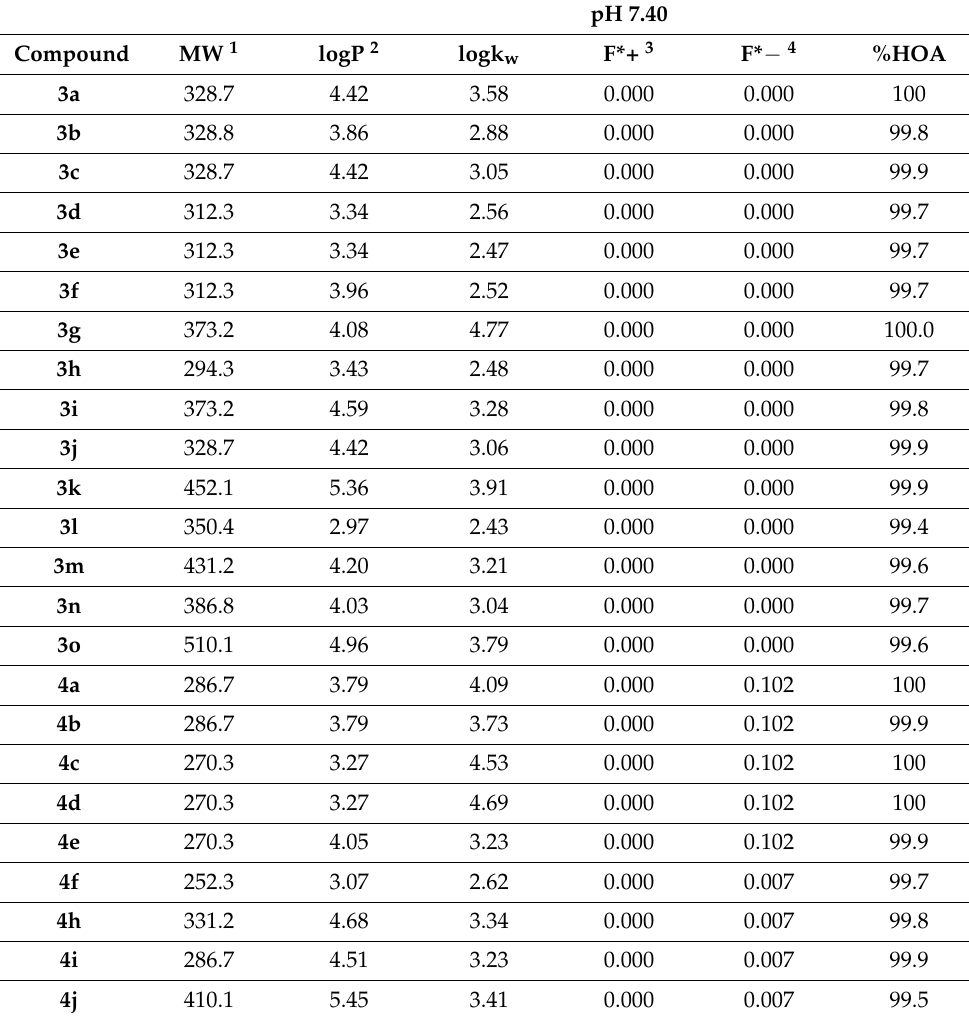
Table 6. Physicochemical properties, chromatographic indexes, and estimated human oral absorp- tion values (%HOA) for each compound using retention factors on the IAM.PC.DD.2 column and additional physicochemical properties (Equation (1)